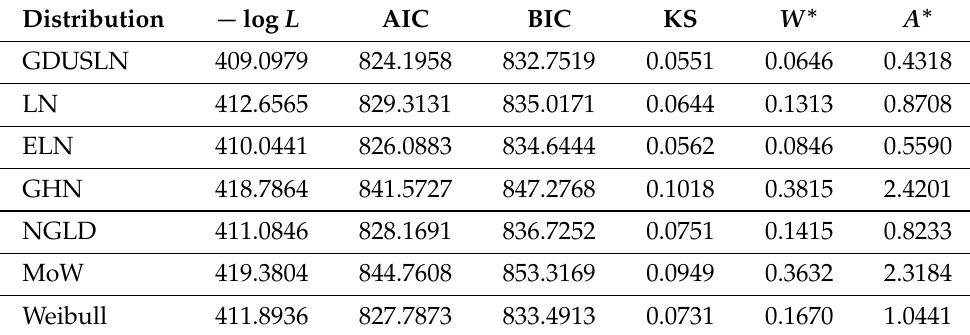
Table 11. Bladder cancer dataset: GOF statistics results.